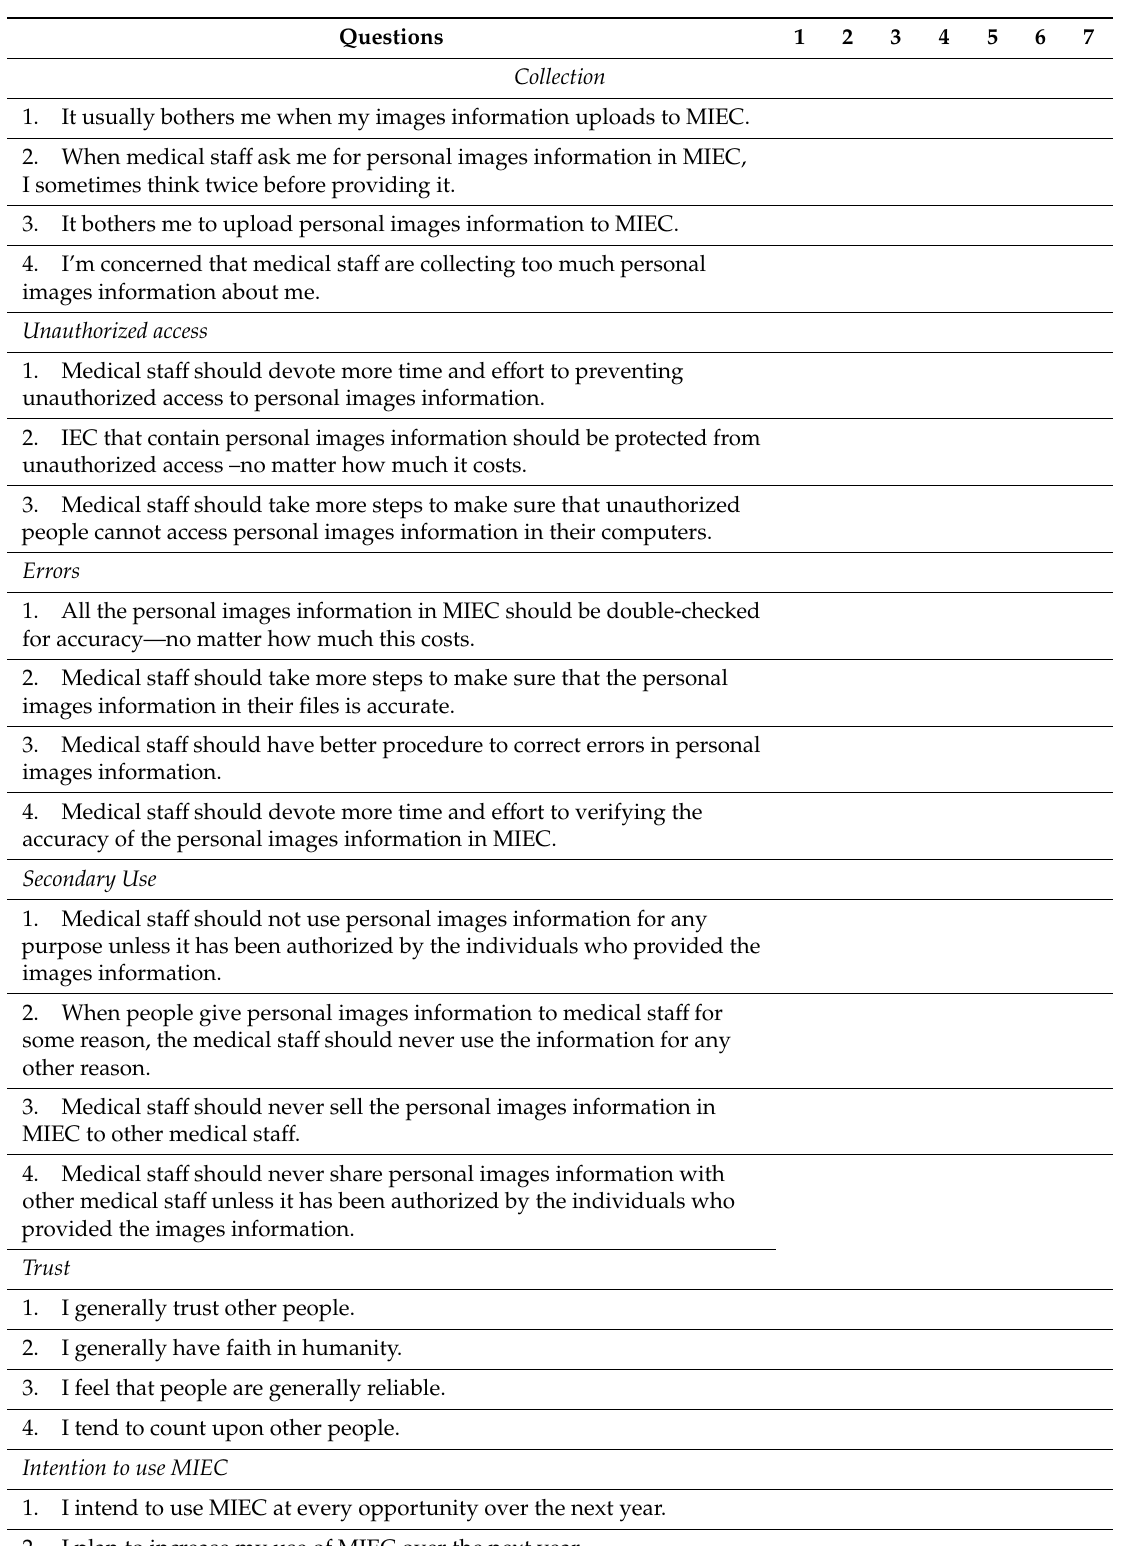
Table A2. Questionnaires: Citizens’ Information Privacy Concerns and Their Intention to Use